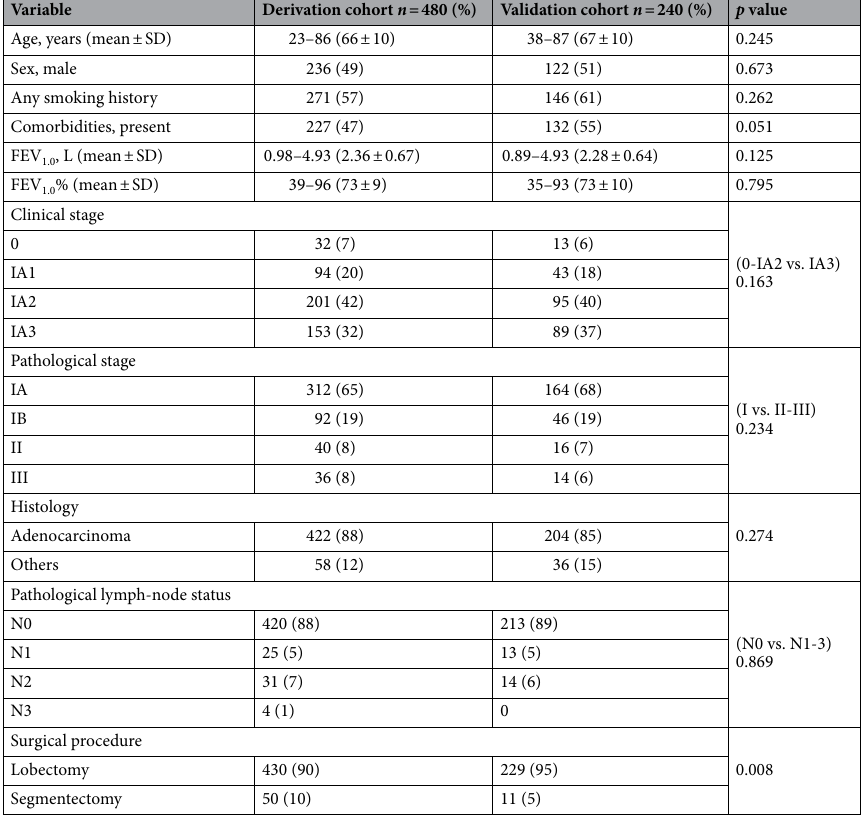
Table 1. Patient characteristics. SD standard deviation; FEV forced expiratory volume.